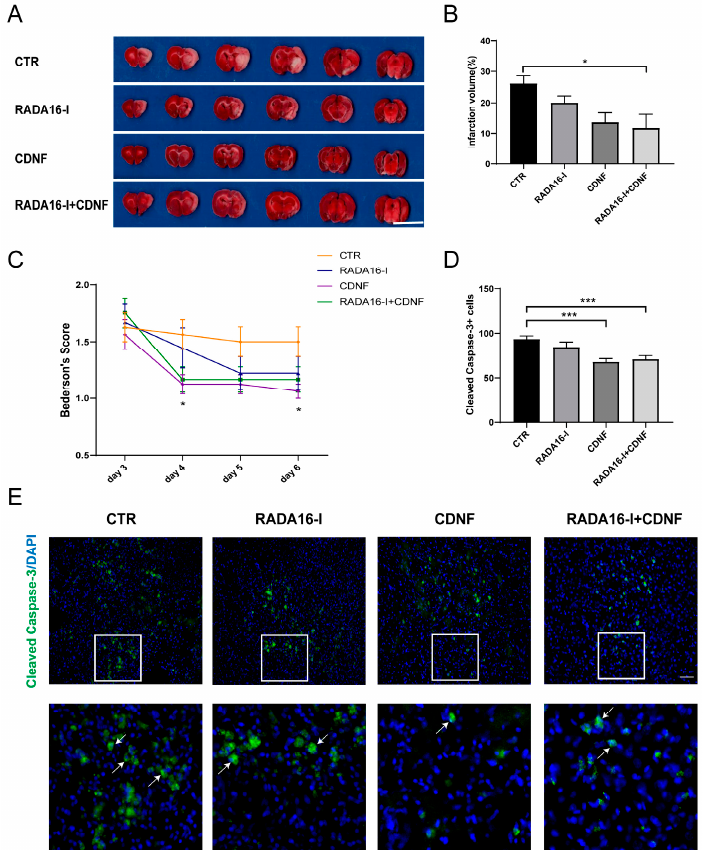
Figure 7. CDNF had a neuroprotective effect in brain ischemia-reperfusion injury. ( A ) TTC staining showing the infarct volume in brain sections. The representative images were placed from the anterior to the posterior portion of the brain. Scale bar = 10 mm. ( B ) The infarct volume was quantified via TTC staining. N = 5/group. ( C ) The Bederson score was assessed in rats on days 3 to 6 after MCAO. N = 10/group. ( D ) Quantitative analysis of the number of caspase-3-positive cells in the peri-infarct cerebral cortex. N = 5/group. ( E ) Cleaved caspase-3-positive cells (red) in the peri-infarct cerebral cortex. DAPI (blue) labeled the nuclei. The insets show photomicrographs of the SVZ at higher magnification. Arrows point to the caspase-3-positive cells. Scale bar = 45 µm. N = 5/group. * p < 0.05; *** p < 0.001 according to ANOVA followed by LSD post hoc analysis.